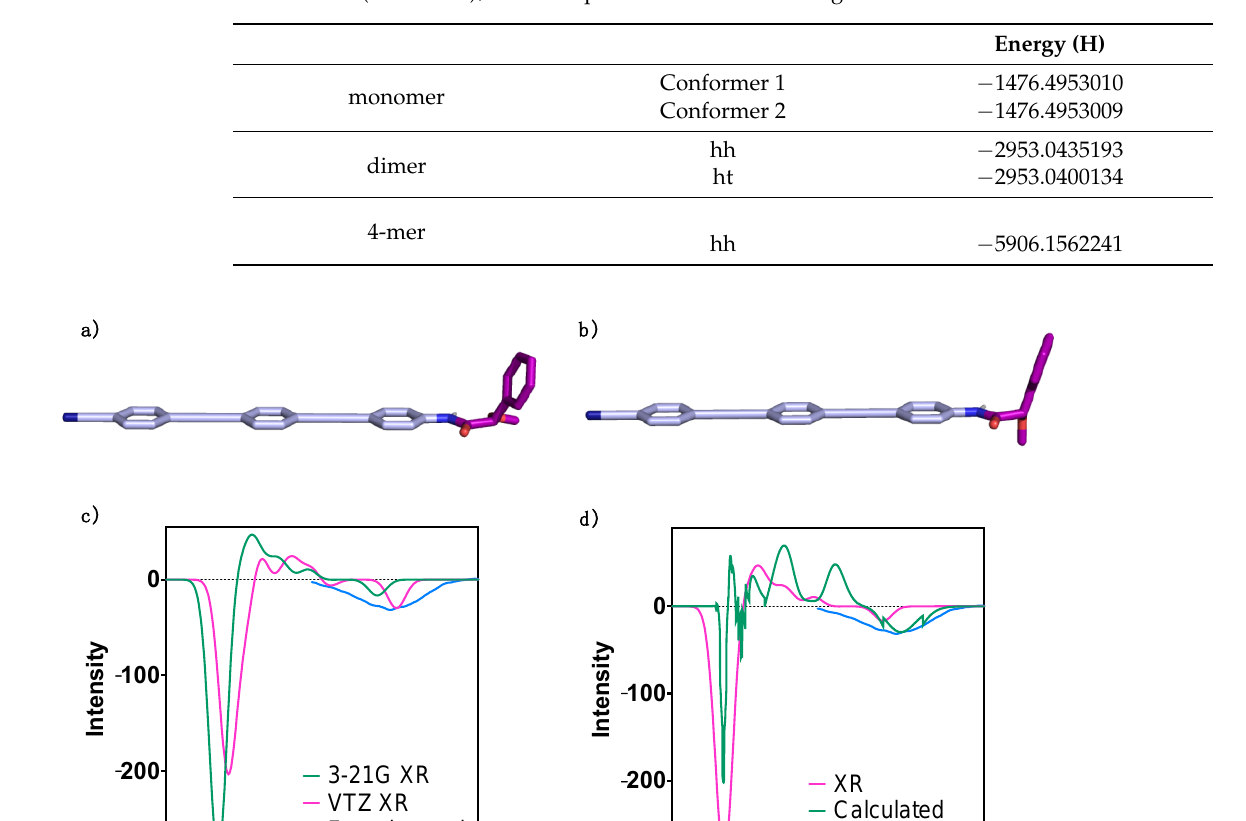
Table 1. DFT(B3LYP-D3)/6-31G** optimized conformer energies.